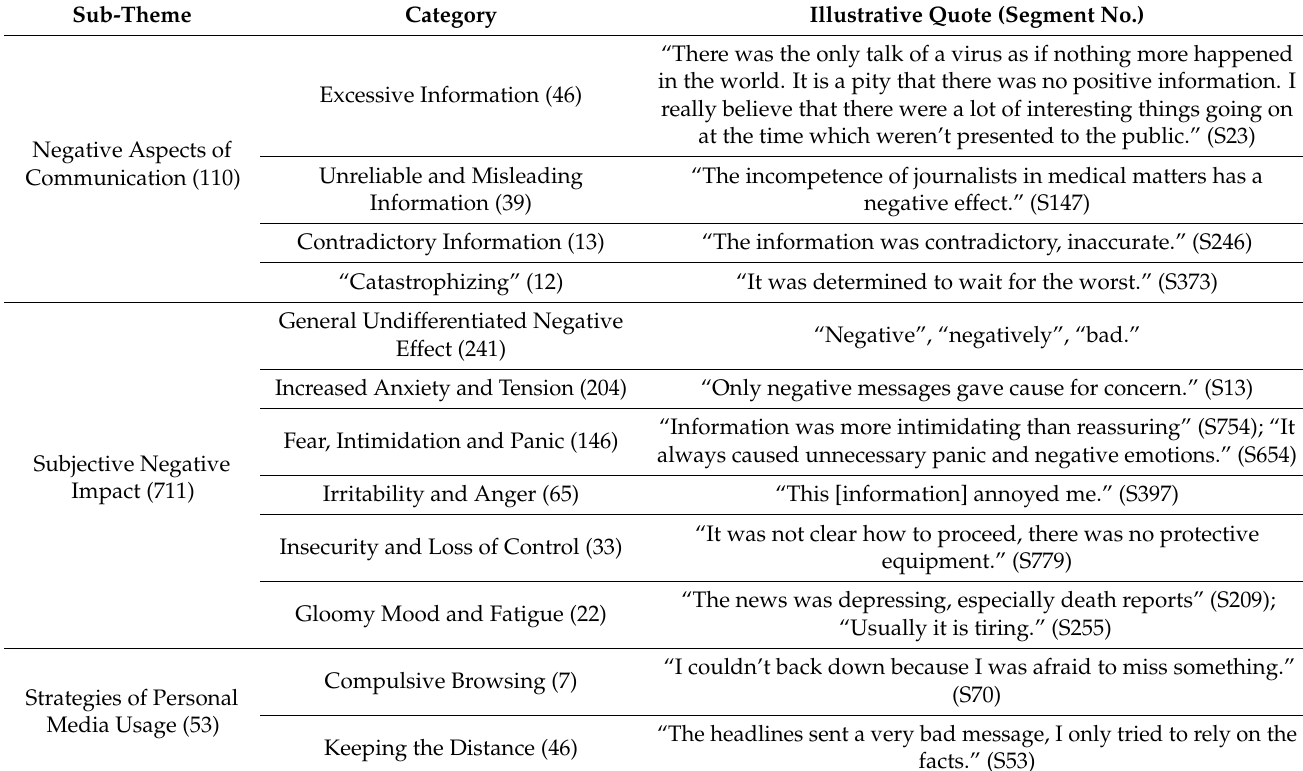
Table 4. Theme: Negative Effects of Communication in the Media: Sub-themes, Categories and Illustrative